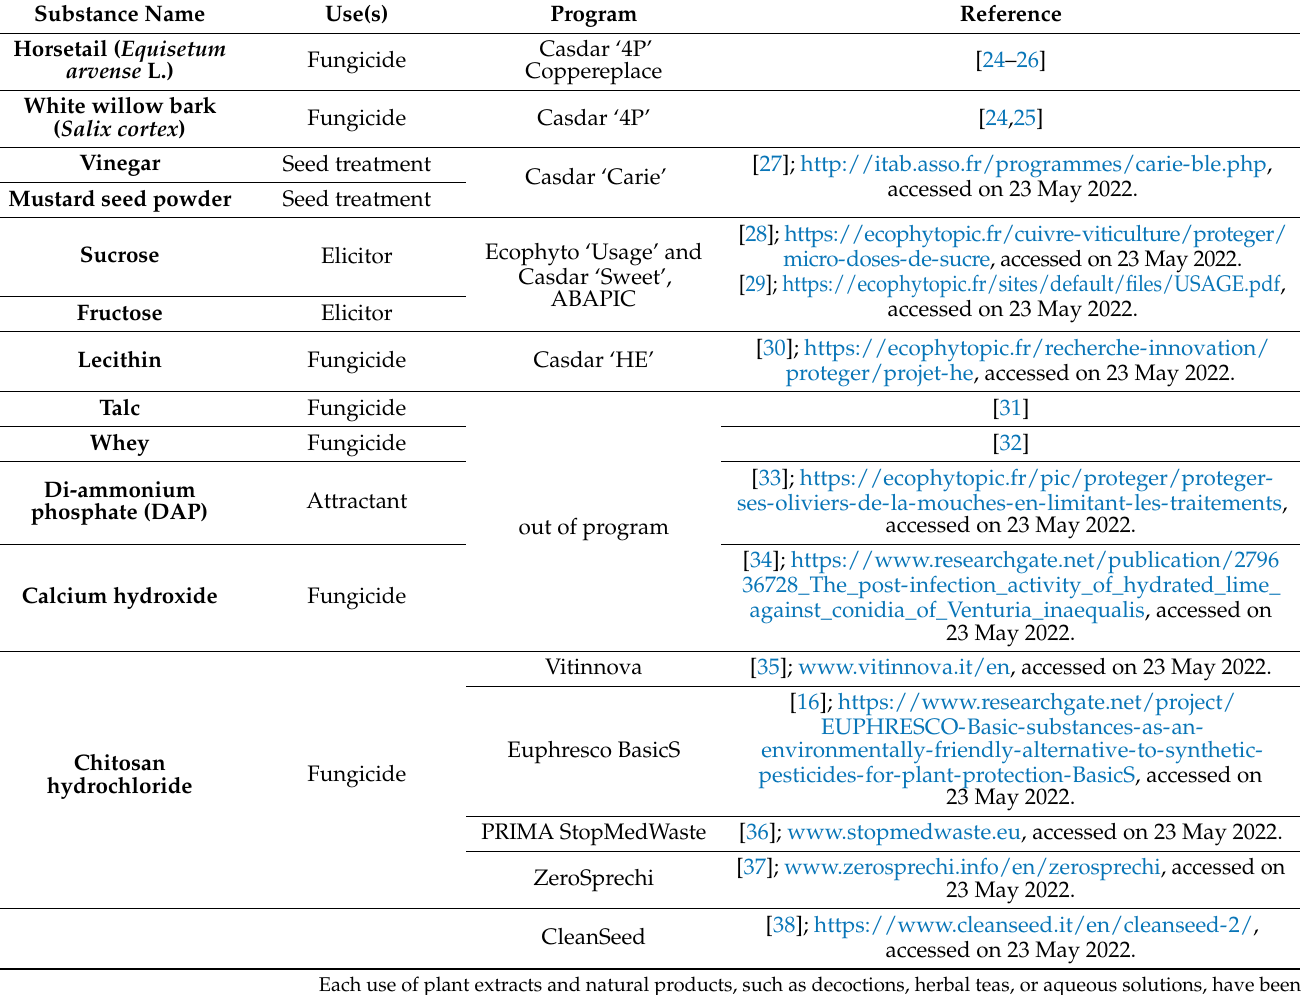
Table 6. Examples of the applications of the basic substances in research